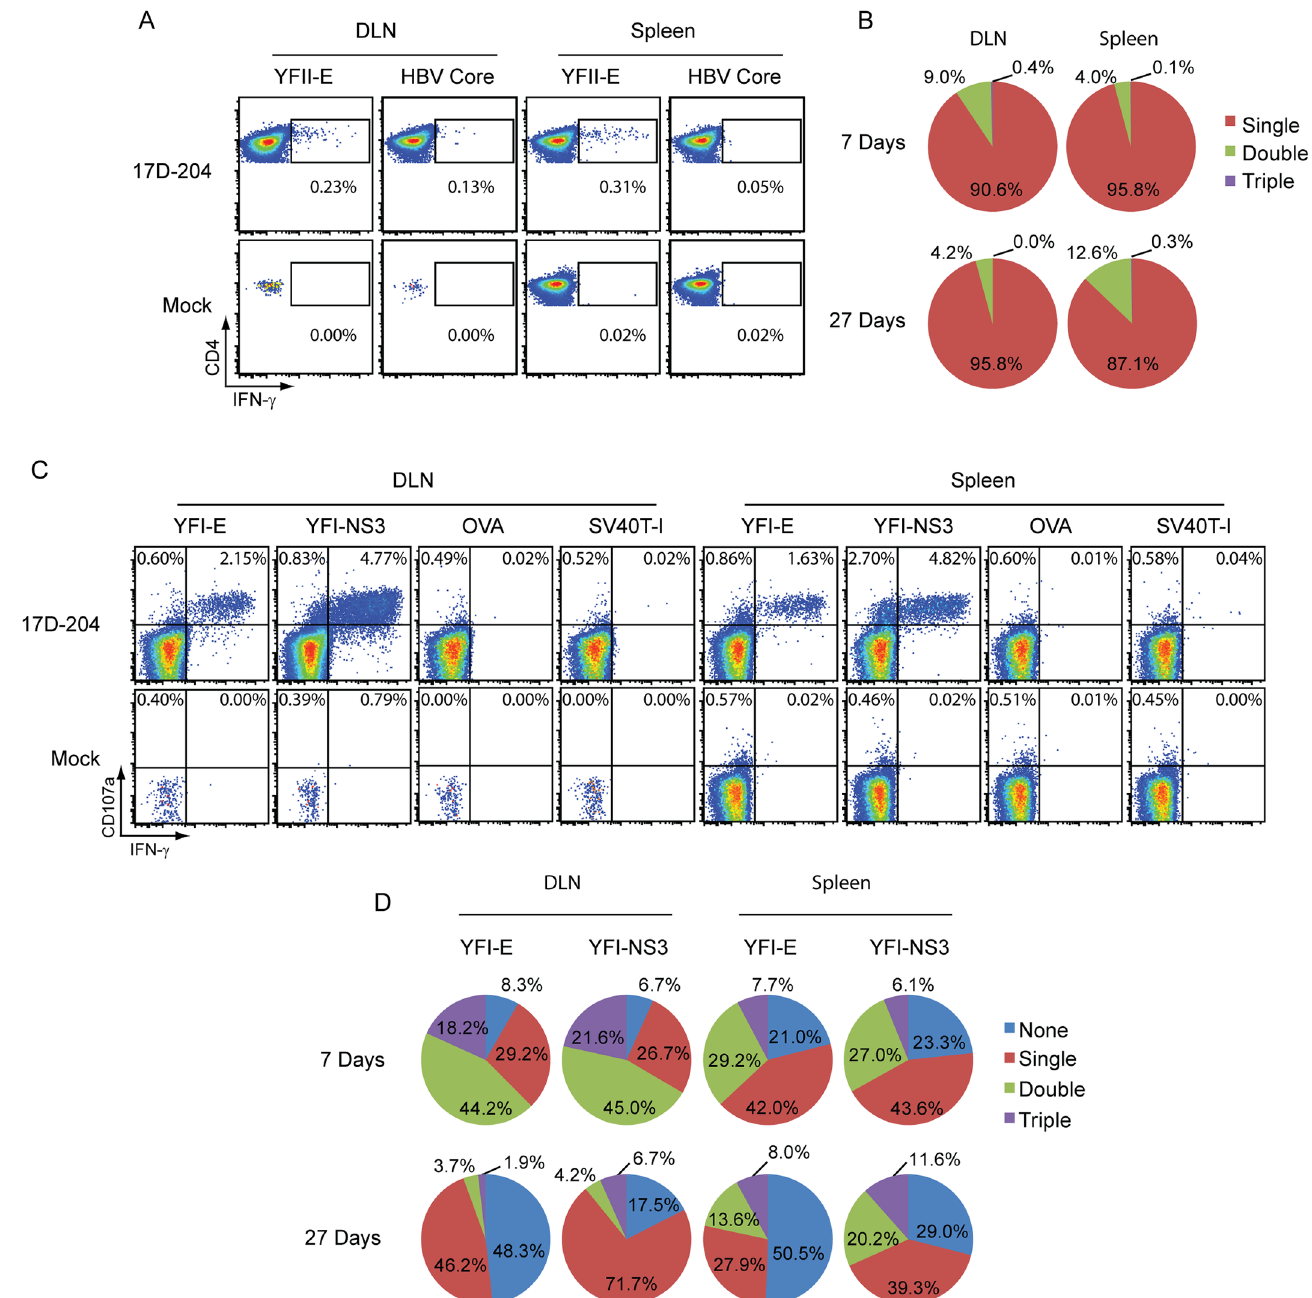
Fig 8. 17D-204-specific T cells are polyfunctional. 5 – 6 week old mice were immunized with 17D-204. On d7 or d27 post immunization DLNs and spleens were harvested and the intracellular cytokine response was measured for (A-B) CD4+ T cells responding to in-vitro restimulation with the YFII-E peptide and (C-D) CD8+ T cells responding to in-vitro restimulation with YFI-E and YFI-NS3 peptides. Total CD4+ T cells were grouped by their ability to respond by producing multiple cytokines; (A-B) IFN γ , TNF α and IL-4 [Single, Double, or Triple]. CD8+,CD107a+ T cells (C-D) were grouped by their ability to produce IFN γ , TNF α and IL-2 [None, Single, Double, or Triple]. The results are representative of two experiments (n = 3 mock, n = 6 17D-204). A and C are representative dot plots. Percentages in A and C are percent of total CD4+ (A) or total CD8+ (C) cells. B and D display the mean percentages across all